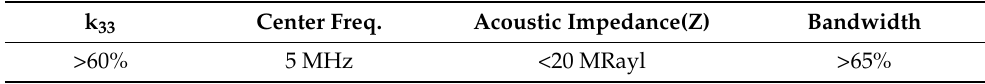
Table 1. Required 2-2 composite transducer performance. k 33 Center